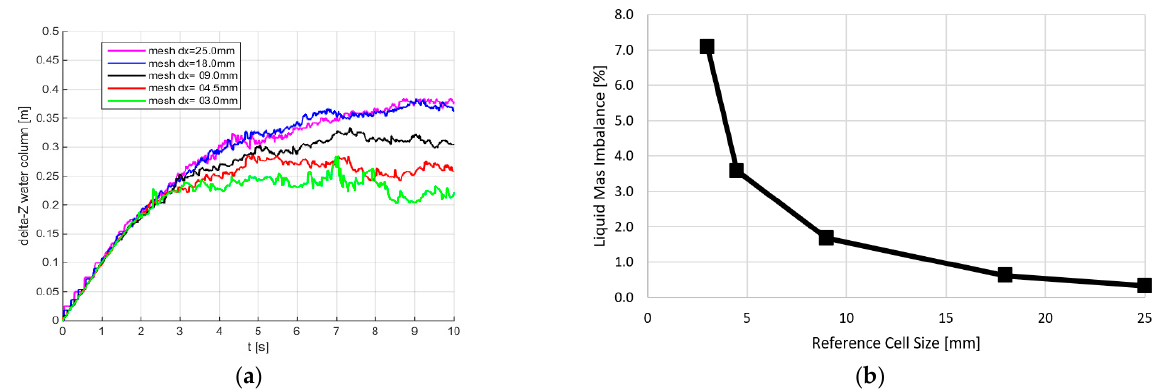
Figure 8. Mesh independence study. ( a ) Variation of water column height. ( b ) Liquid mass imbalance.